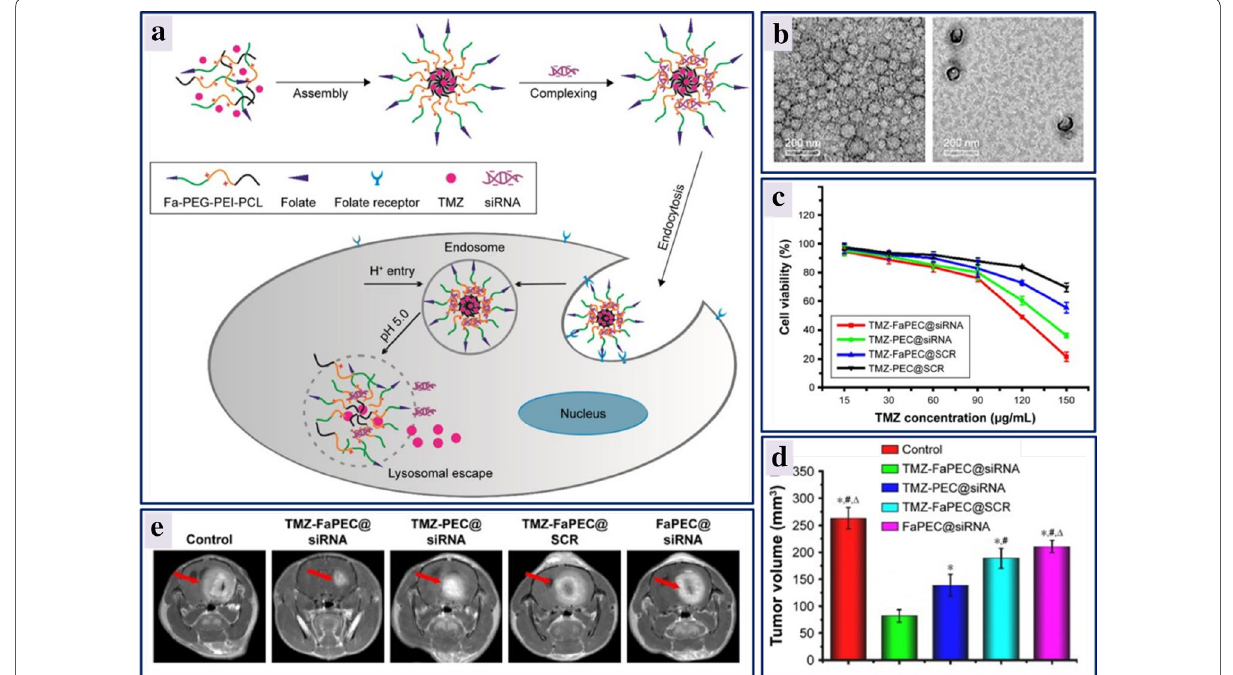
Fig. 8 Illustration of TMZ (temozolomide) and siRNA conjugated preparation of folic acid decorated Fa-PEG-PEI-PCL and release of antitumor therapeutics inside the cancer cells ( a ); TEM images showing TMZ-conjugated, folic acid-decorated PEC micelle (left) and TMZ and siRNA-conjugated, folic acid-decorated PEC micelle (right) at pH 7.4. All samples were stained with 0.5% uranyl acetate for 1 min. Scale bar: 200 nm ( b ); in vitro cytotoxicity effect of different nanocomplexes on C6 cells evaluated by CCK8 assay at various TMZ concentrations. Cells were incubated for 48 h and BCL-2 siRNA concentration used is 20 nM ( c ); Mean tumor volume determined using magnetic resonance imaging measured